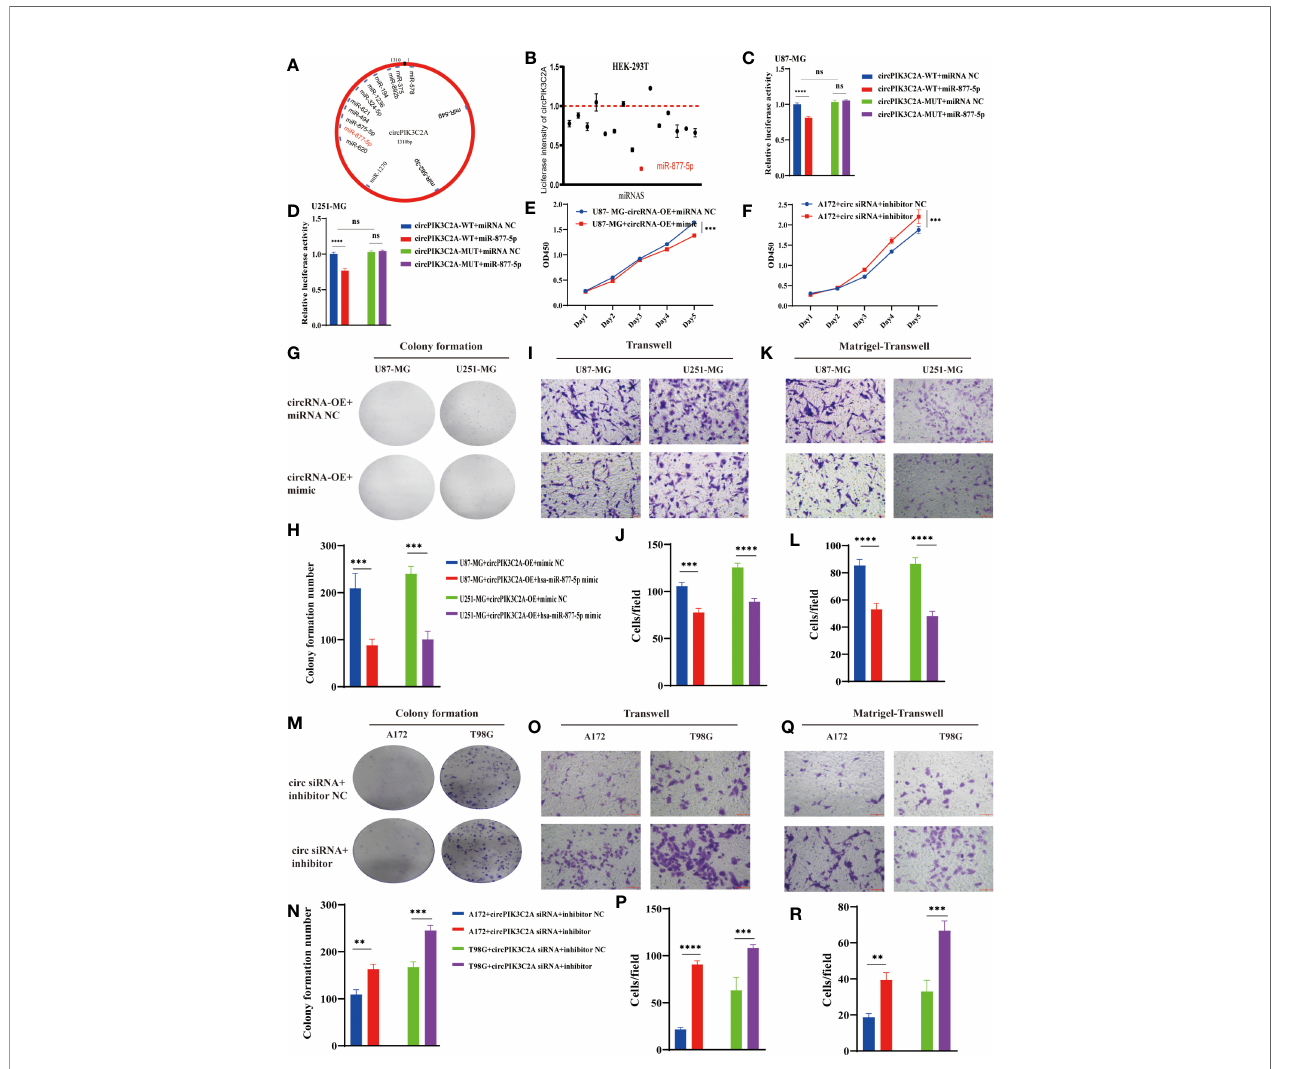
FIGURE 3 | CircPIK3C2A function as a miR-877-5p sponge. (A) A schematic model shows the putative binding sites of 14 predicted miRNAs on circPIK3C2A. (B) Luciferase activity of circPIK3C2A in HEK293T cells transfected with miRNA mimics which are putative binding to the circPIK3C2A sequence. Luciferase activity was normalized by Renilla luciferase activity. (C, D) Luciferase activity assay was carried out to verify that miR-877-5p targets circPIK3C2A directly in GBM cells. (E, F) CCK-8 assays were performed after cells were co-transfected with different vectors. (G – L) Colony formation analyses (G, H) , transwell analyses (I, G) and matrigel-transwell analyses (K, L) of U87-MG and U251-MG with or without circPIK3C2A-OE+hsa-miR877-5p mimic were performed. Representative staining images are presented (magni fi cation: 200×; scale bar = 100 m m). (M – R) Colony formation analyses (M, N) , transwell analyses (O, P) and matrigel-transwell analyses (Q, R) of A172 and T98G with or without circPIK3C2A siRNA+hsa-miR-877-5P inhibitor were performed. Representative staining images are presented (magni fi cation: 200×; scale bar = 100 m m). Data are presented as the mean ± SEM of 3 independent experiments. Signi fi cant results are presented as ns P < 0.05, **P < 0.01, ***P < 0.001, and ****P <